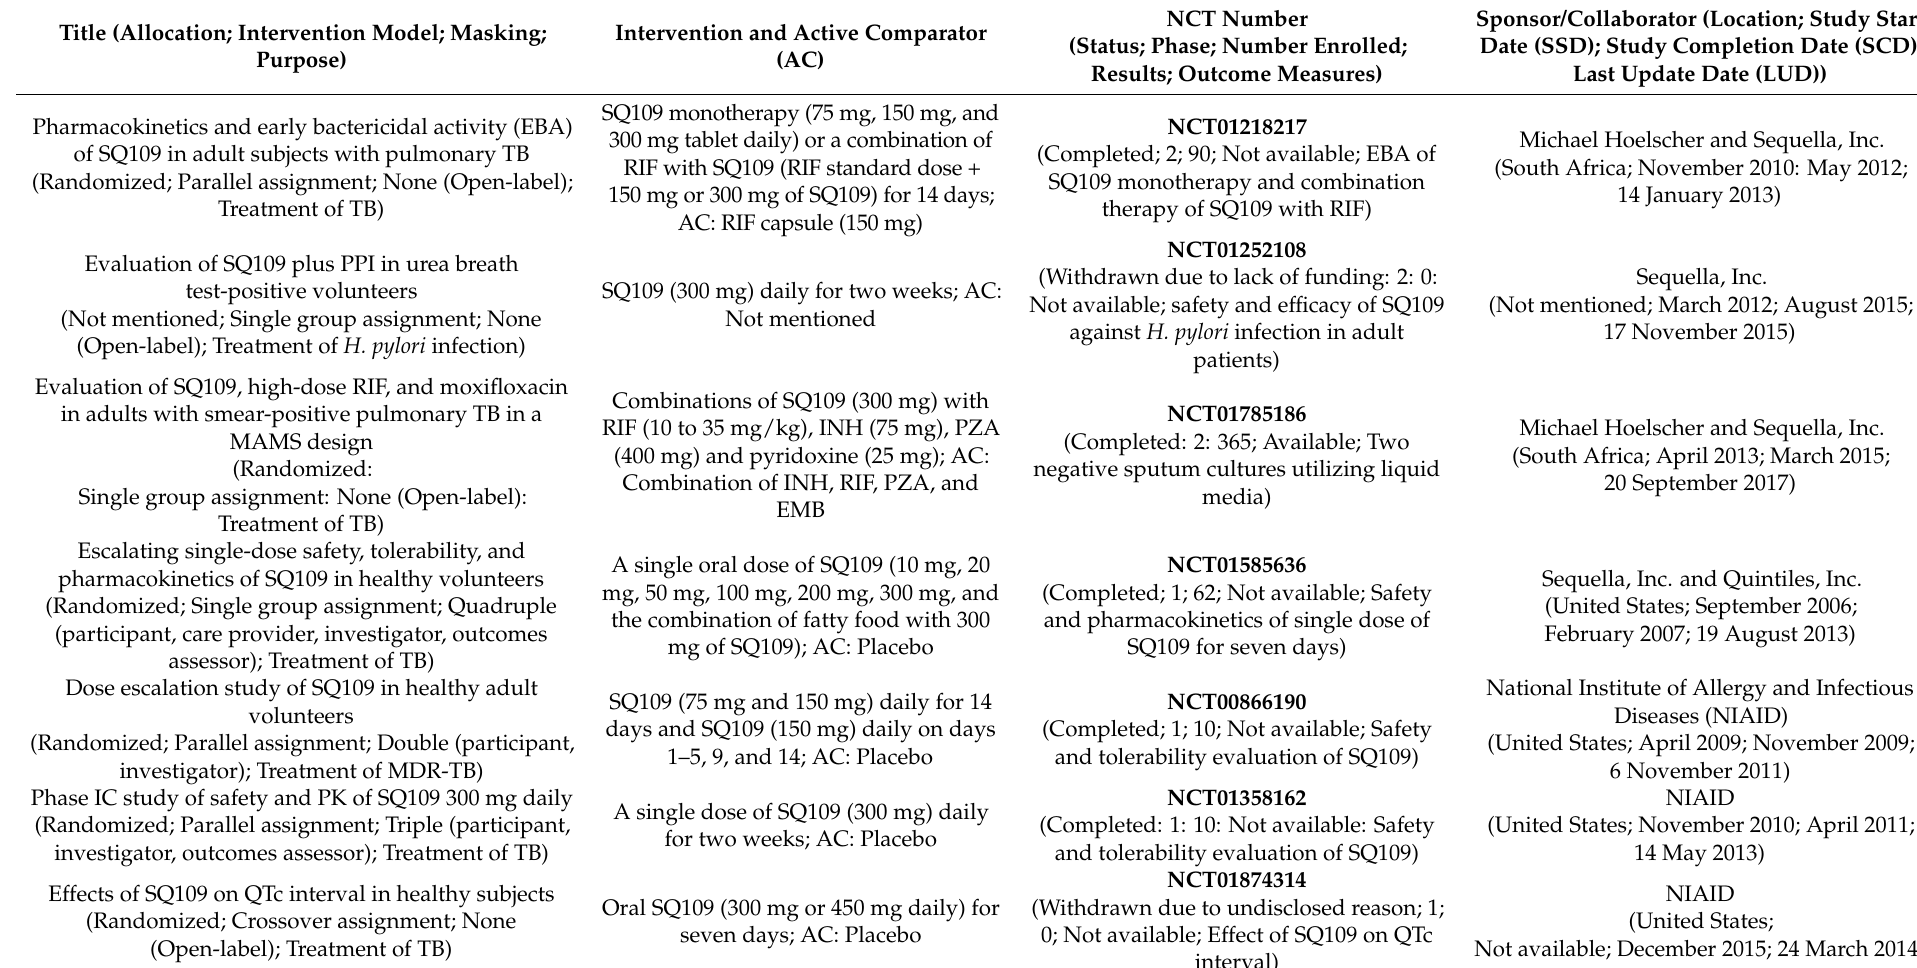
Table 3. Summary of clinical studies on